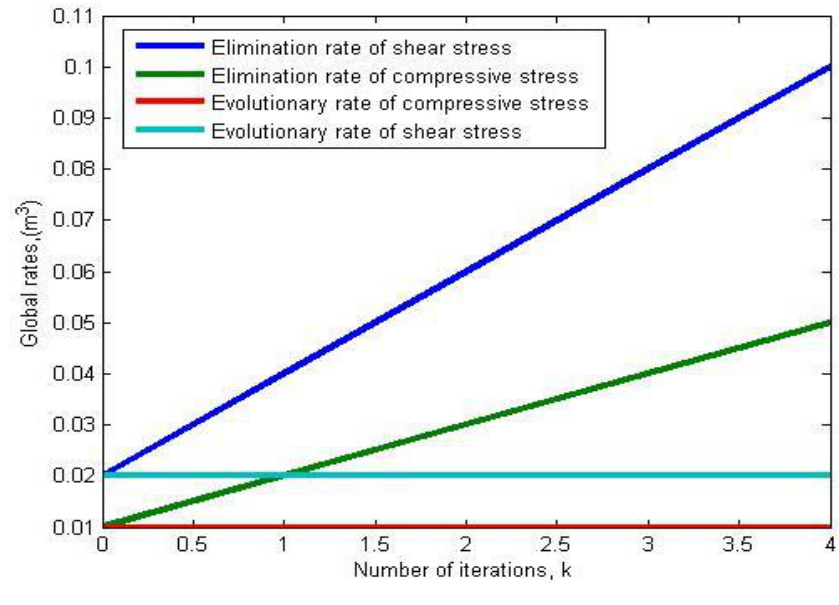
Figure 8. Elimination and evolutionary